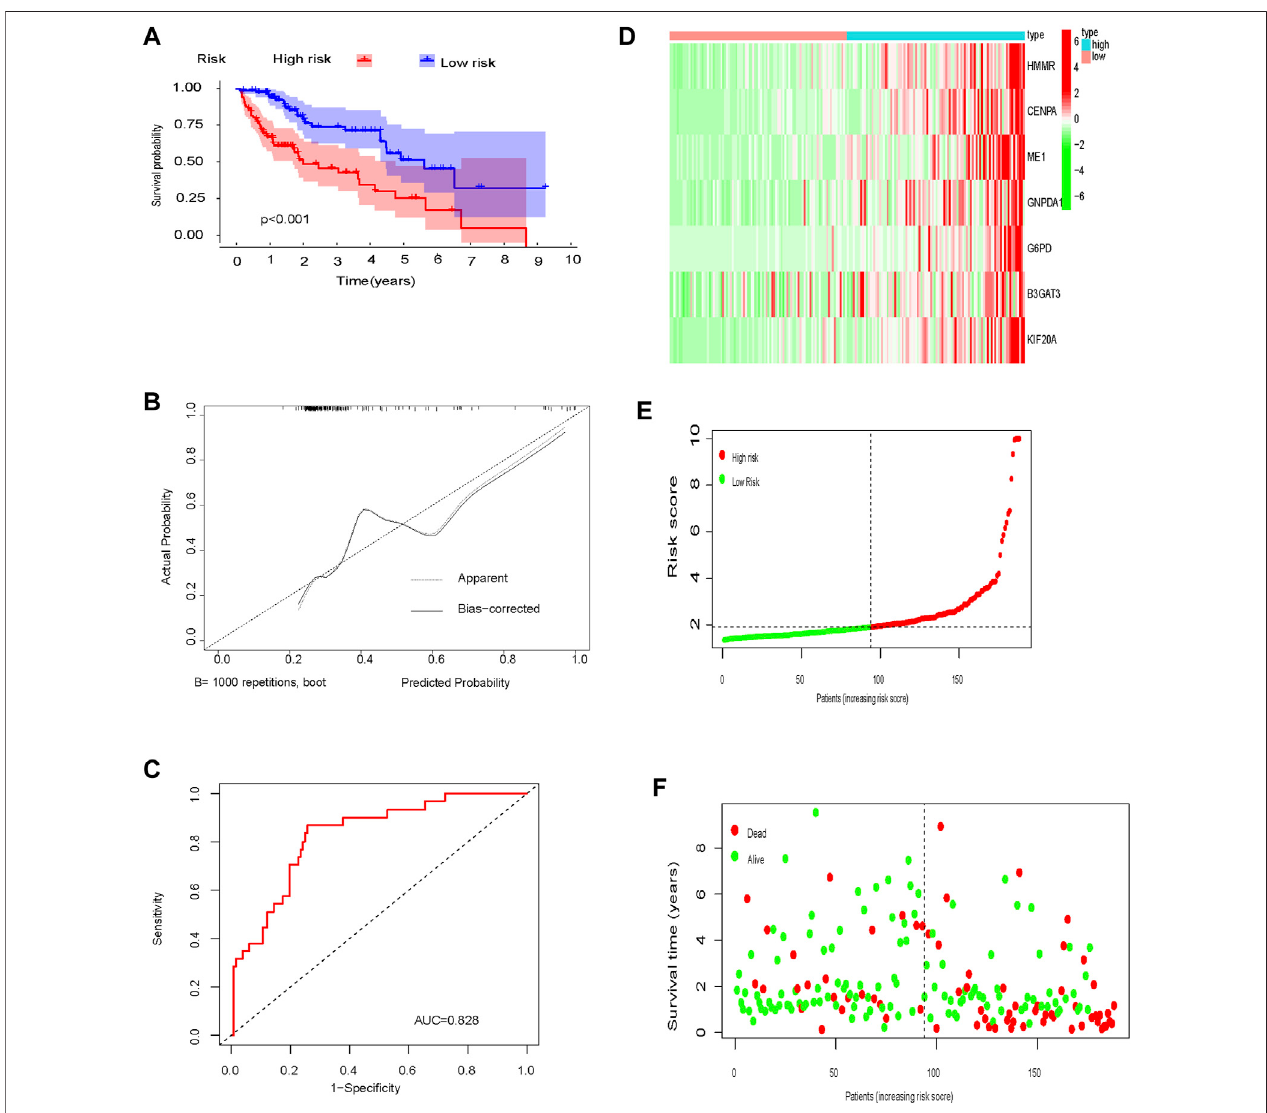
FIGURE 5 | Training set (A) Kaplan-Meier curve; (B) Calibration curve; (C) Time-dependent ROC curve analysis; (D) Heat map of glycolysis-related gene expression; (E) Distribution of risk scores; (F) Survival time.